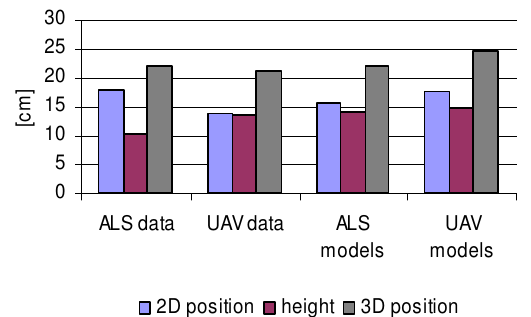
Fig 3.5: Mean residuals between Check Points, calculated with respect to the data collected by tacheometer.